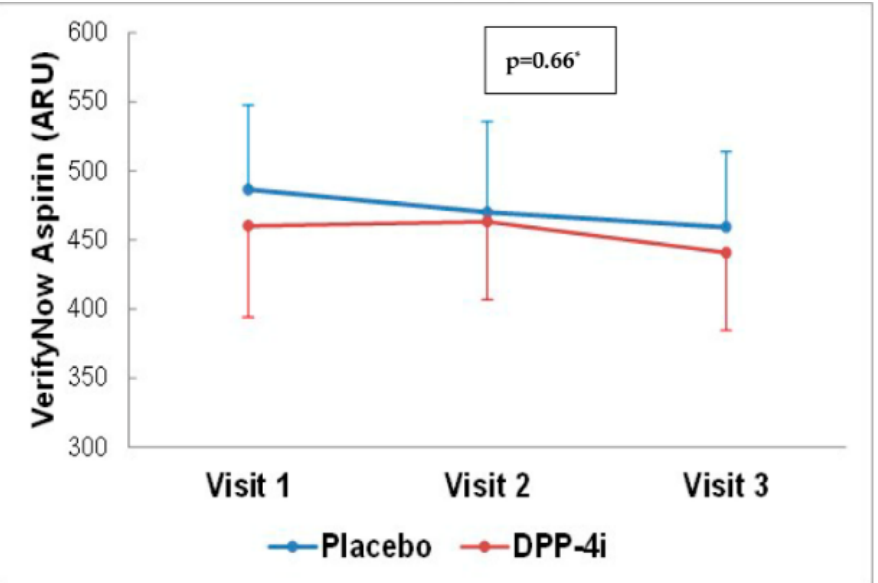
Figure 3. Effects of DPP-4i on Platelet reactivity (Mean ± SD) by VerifyNow Aspirin. Visit 1:baseline Visit 2: 4 ± 2 days. Visit 3: 30 ± 5 days. Visit 1: Placebo (486.45 ± 61.00); DPP-4i (460.13 ± 66.22). Visit